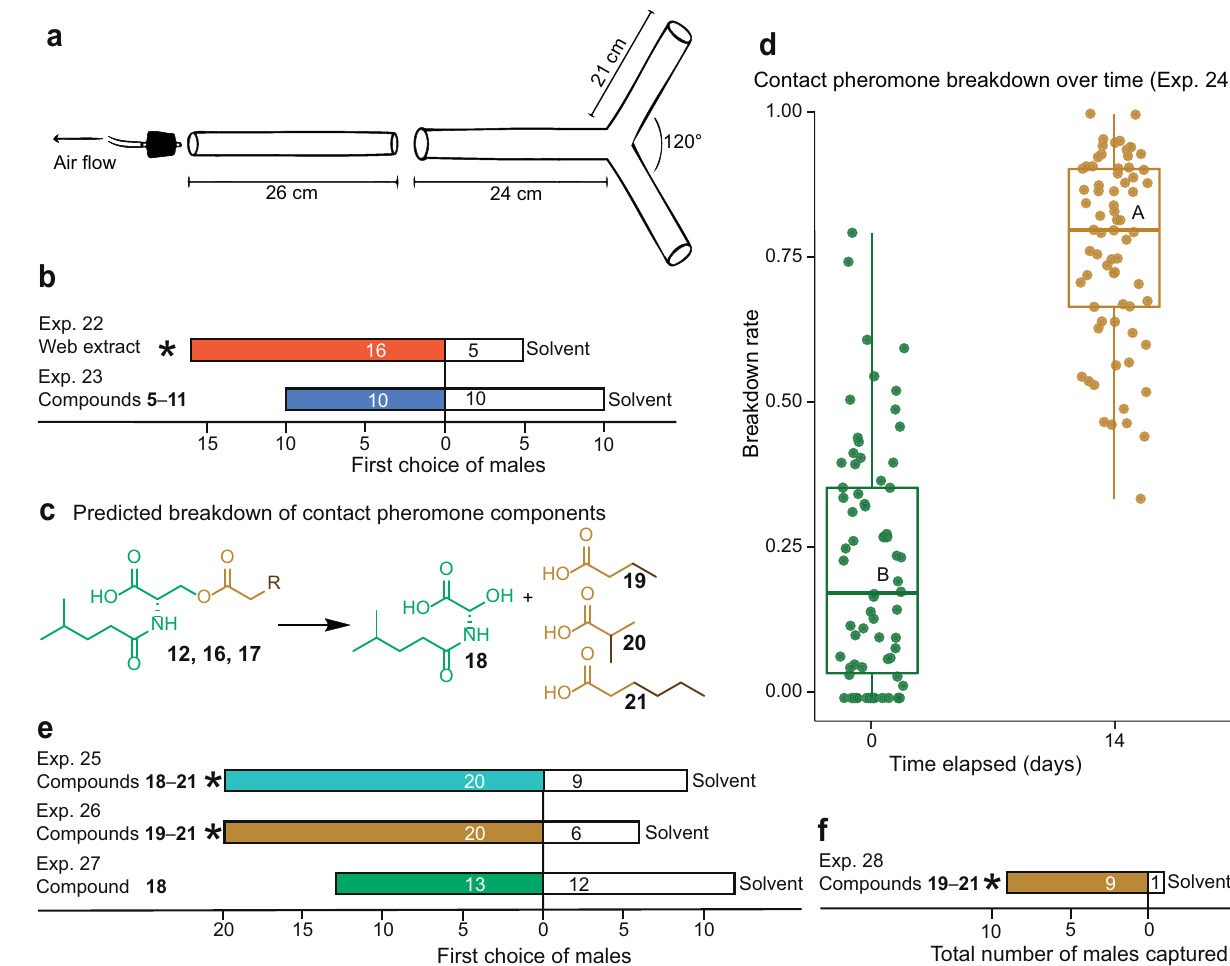
Fig. 4 Transition of contact pheromone components produced by female Steatoda grossa to sex attractant pheromone components. a Moving-air dual- choice Y-tube olfactometer. b Attraction of S. grossa males in Y-tube olfactometers to extracts of female webs and to volatile compound 5 – 11 (names